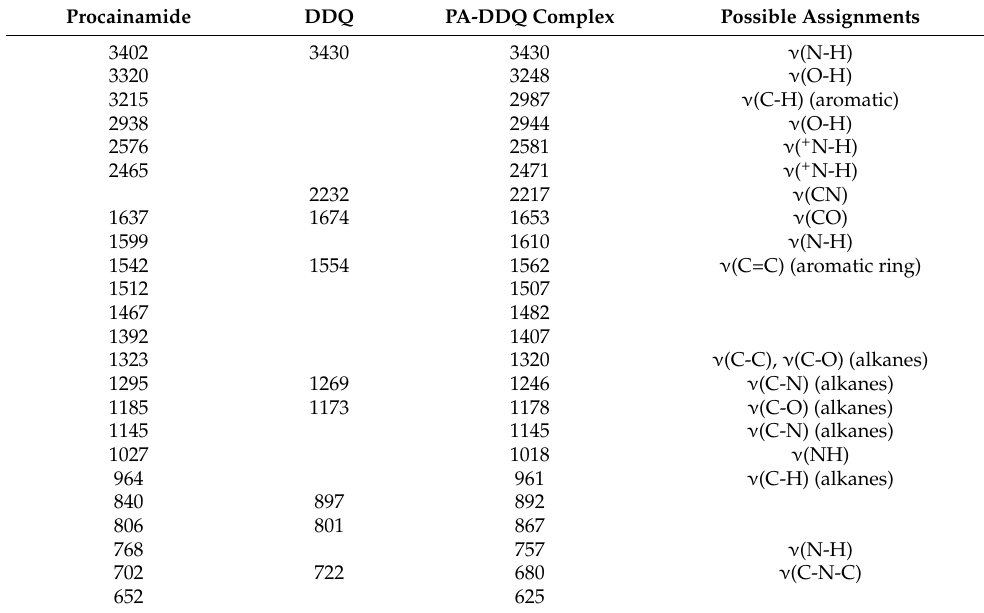
Table 3. IR spectral bands of PA, DDQ, and their complex (PA-DDQ).